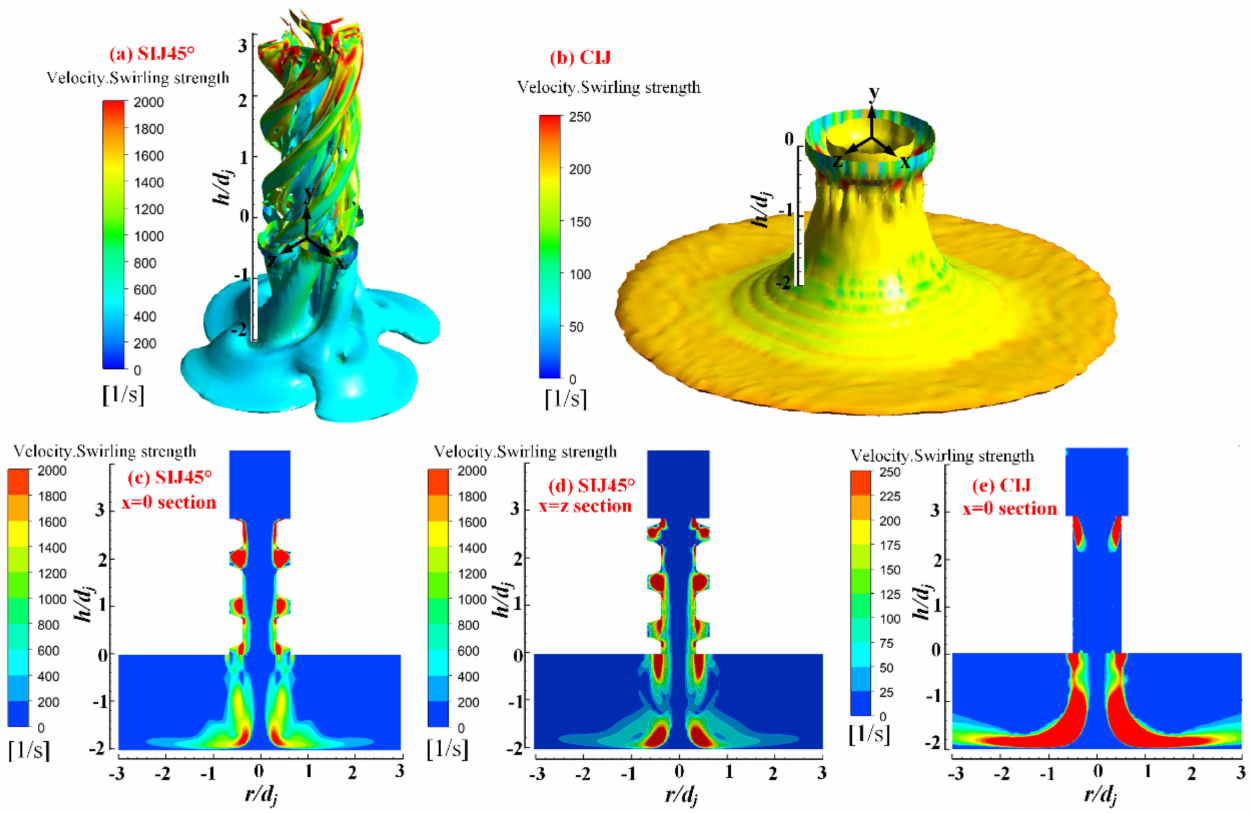
Figure 9. Vortex contour ( Re = 4000, h/d j = 2): ( a ) SIJ 45 ◦ , ( b ) CIJ, ( c )in the x = 0 section for SIJ 45 ◦ , ( d ) in the x = z section for SIJ 45 ◦ , and ( e ) in the x = 0 section for